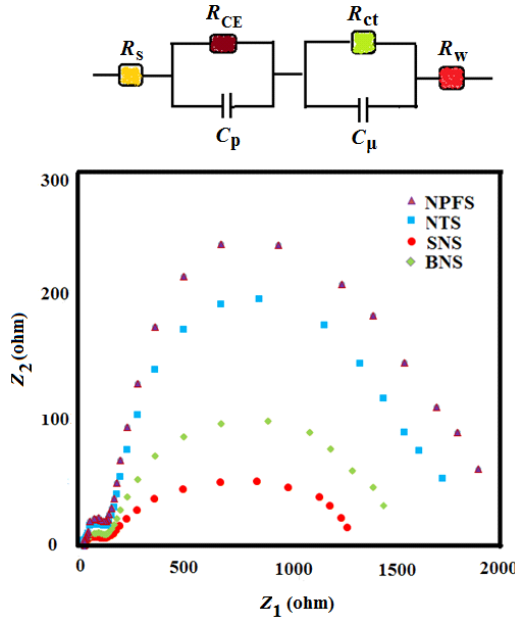
Fig. 7 EIS spectra of different photoanode electrodes